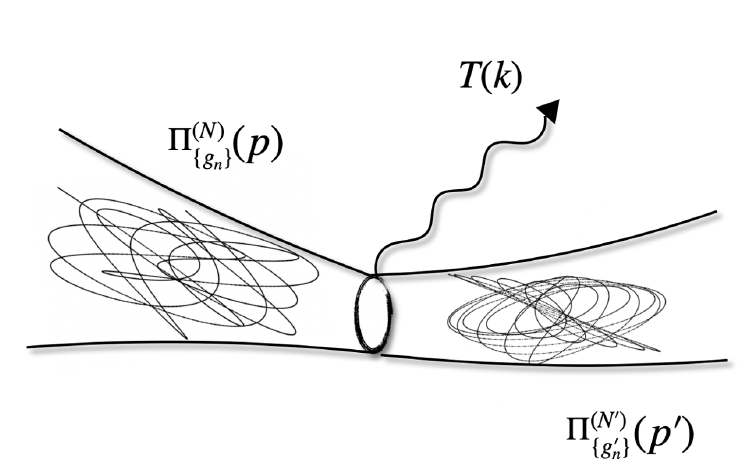
decays into { g n }